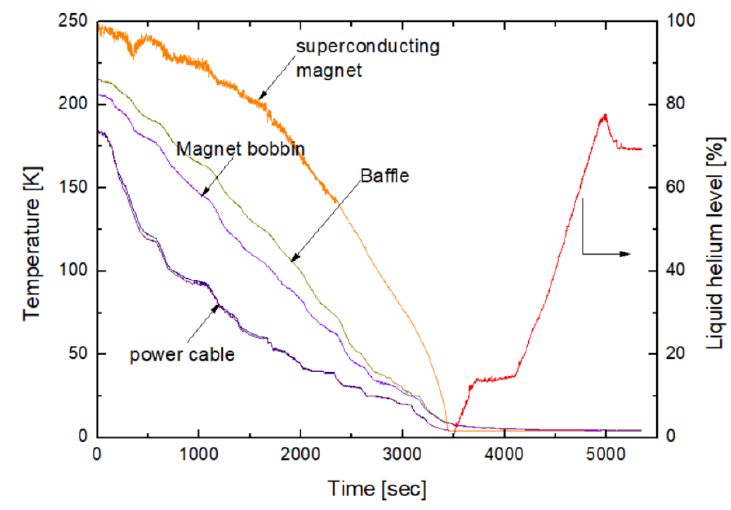
Figure 9. Cool-down curve for the 5 tesla superconducting magnet system.